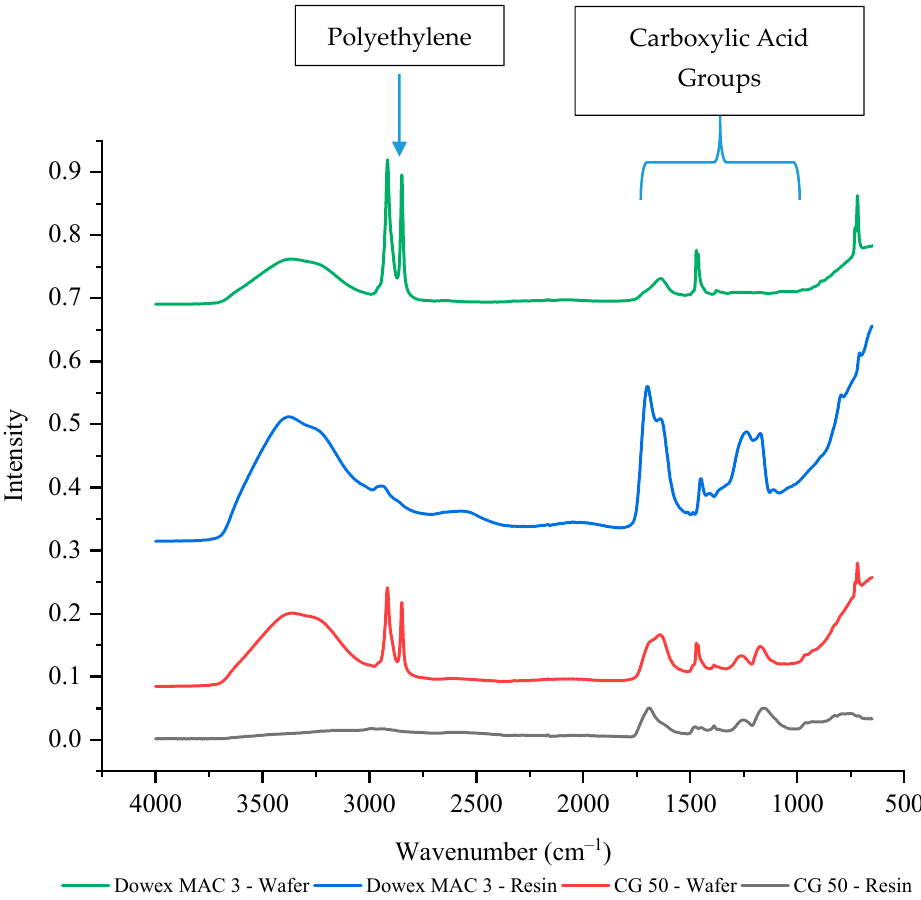
Figure 7. The FTIR-ATR spectrum of weak cation exchange resins and wafers formed using these resins. To confirm that the bead resins led to less availability of the function groups, two different batches and multiple wafer positions of Dowex MAC 3 H + resin wafers were tested by FTIR-ATR. In both batches, the intensity of the carboxylic acid functional groups was significantly reduced at both the edge and the middle with intensity values of around 10–18% of the resin alone (Figure 8, Supplementary Table S2). It is interesting to note that this reduction did not appear to have any effect on the performance of the Dowex MAC 3 H + resin wafer unlike what was observed with the strong cation exchange resin bead (IR 120 Na + ).